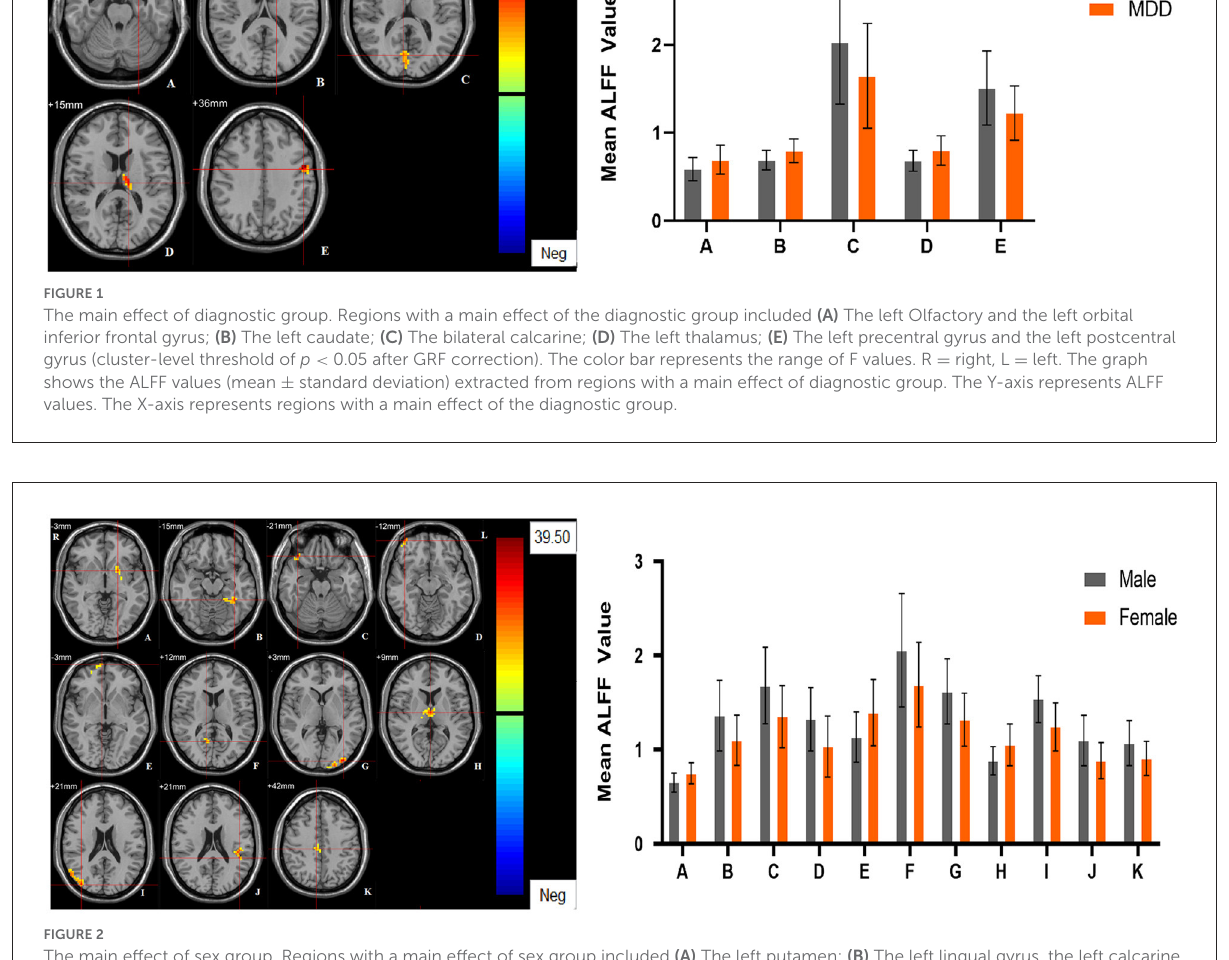
calcarine, right orbital inferior frontal gyrus, right orbital middle frontal gyrus, right postcentral gyrus, left middle occipital gyrus compared to male participants (Table 4, Figure 5). The left Calcarine, right median cingulate gyrus, left dorsolateral superior frontal gyrus were significantly observed in diagnosis sex interaction. A post hoc test indicated that women with MDD had significantly decreased ReHo value in the left Calcarine compared with HC females ( P < 0.005, Bonferroni correction) and men with MDD ( P < 0.005, Bonferroni correction). In the left dorsolateral superior frontal gyrus, women with MDD had significantly decreased ReHo value compared with HC females ( P < 0.01, Bonferroni correction), while men